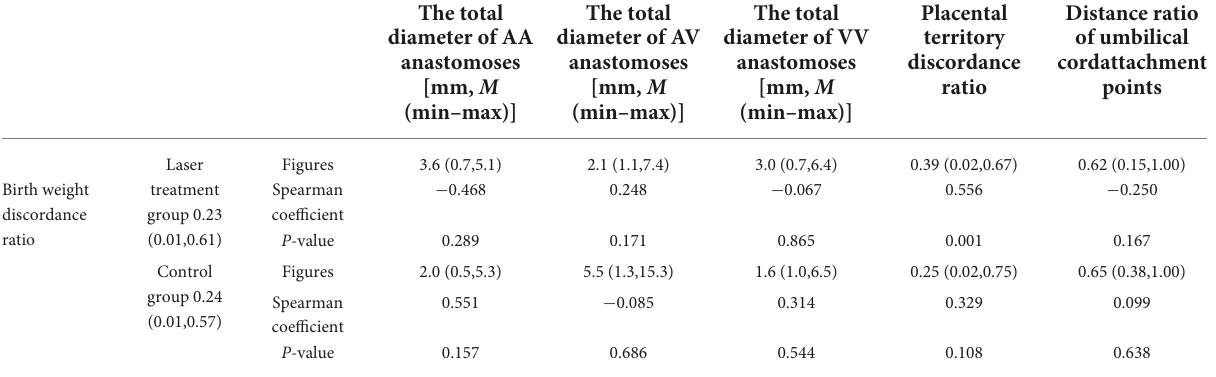
TABLE 3 Correlation between birth-weight discordance ratio and the placental structure characteristics in the two study